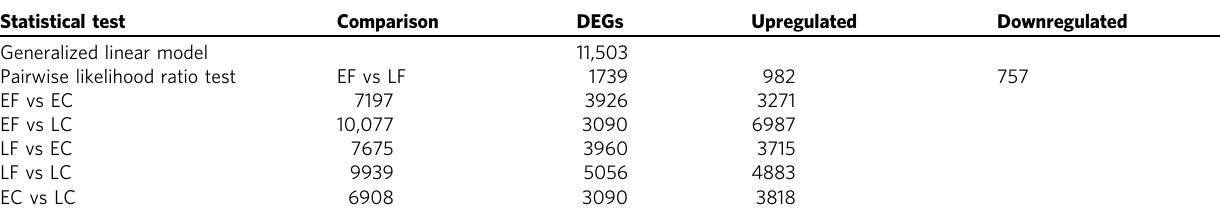
Table 1 Statistical comparison of gene expression across four groups of stage CV Calanus that differed by source ( fi eld/diapause program vs. culture/reproductive program) and time point (early vs. late).